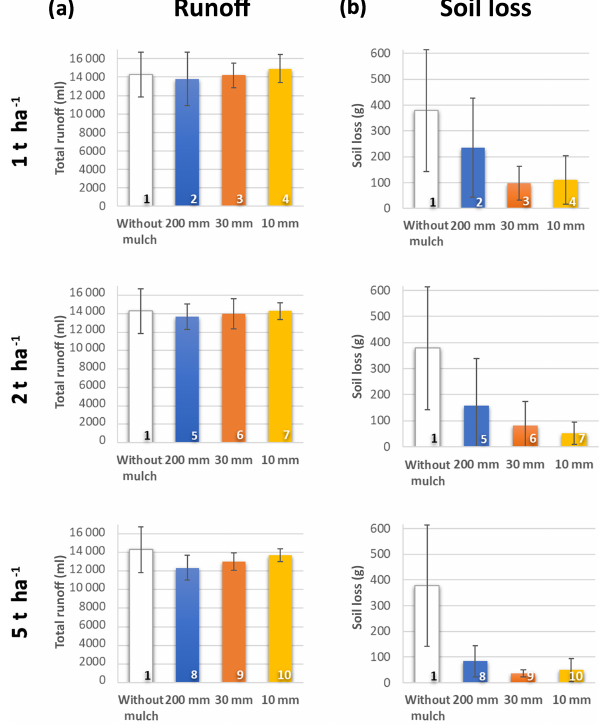
Figure 5. Response to constant intensity simulated rainfall: total (a) runoff and (b) soil loss for each scenario (bare soil and nine combinations of mulch size and application rates, see Table 3). Av- erage and standard deviation bars are for 3 repetitions.